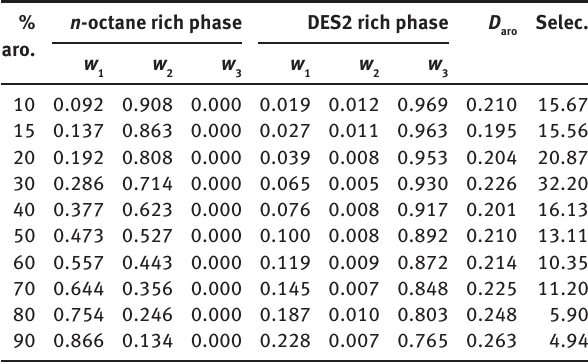
Table 3: LLE experimental data with DES2. % aro.